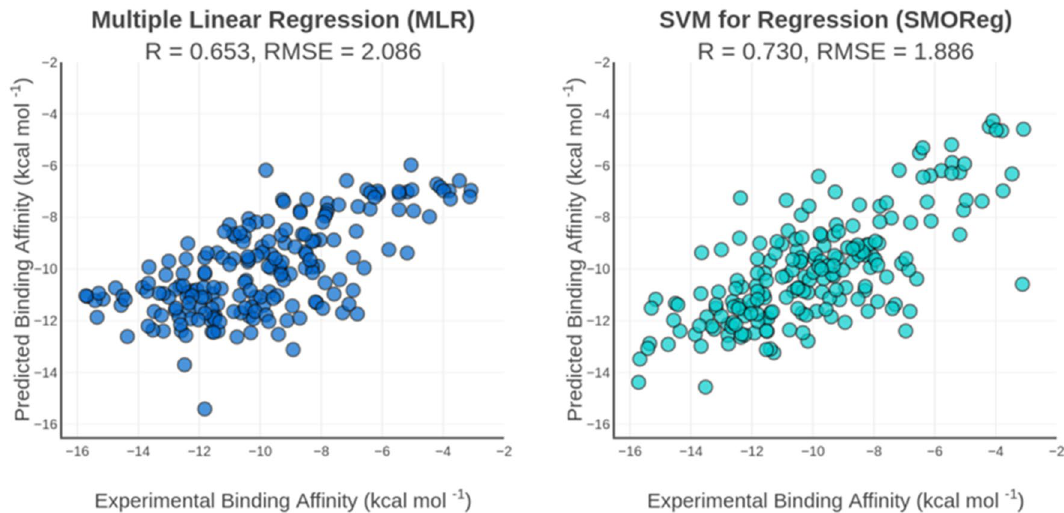
Figure 3. Correlation plot of experimental and predicted binding affinities by MLR (left) and SMOReg (right) specific scoring functions for proteases. The scoring functions were evaluated on the independent test set for proteases (N = 196). R is the Pearson’s correlation coefficient and RMSE is the root mean squared error given in kcal mol −1 . Scoring functions